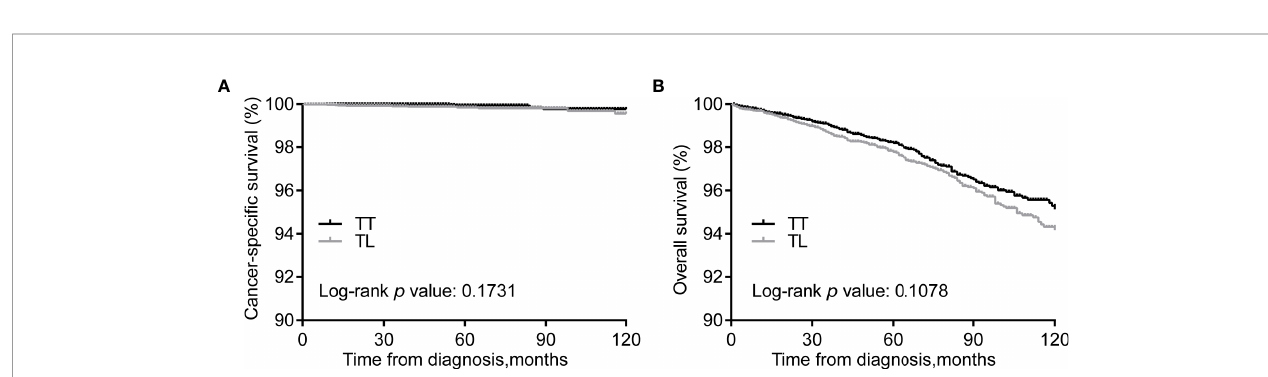
FIGURE 1 | Kaplan-Meier curves of CSS (A) and OS (B) of PTMC patients undergoing TT versus TL before propensity score matching. CSS, cancer speci fi c survival; OS, overall survival; PTMC, papillary thyroid microcarcinoma; TT, total thyroidectomy; TL, thyroid lobectomy.